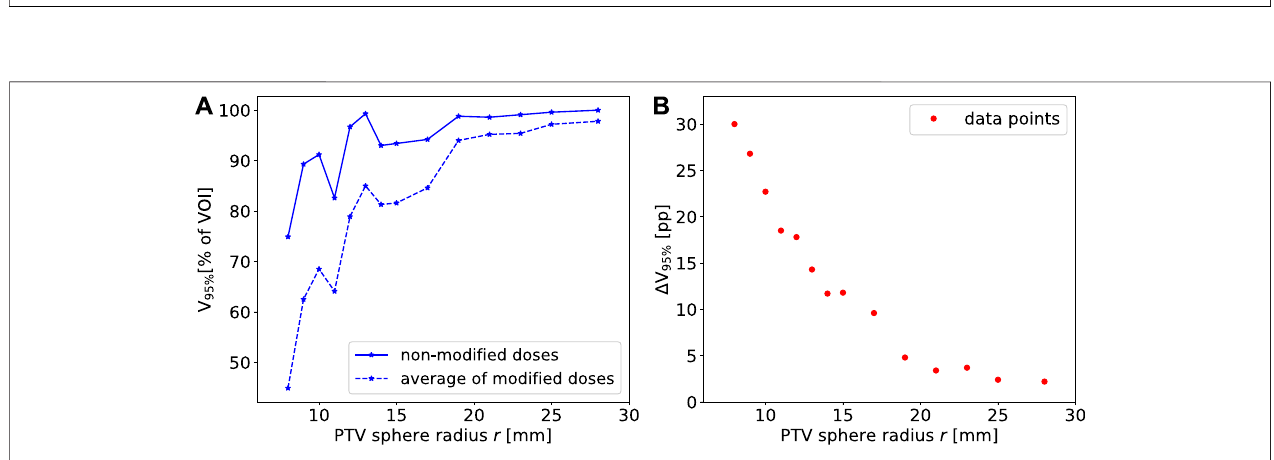
FIGURE 5 | (A) The PTV V 95% for the non-modulated and modulated cases for spherical PTVs with variable radii at d ic (cid:1) 100 mm with P mod (cid:1) 0.400 mm. All plans are for carbon ions. (B) The relative difference in PTV V 95% , i.e., the difference of the two curves represented in (A) .